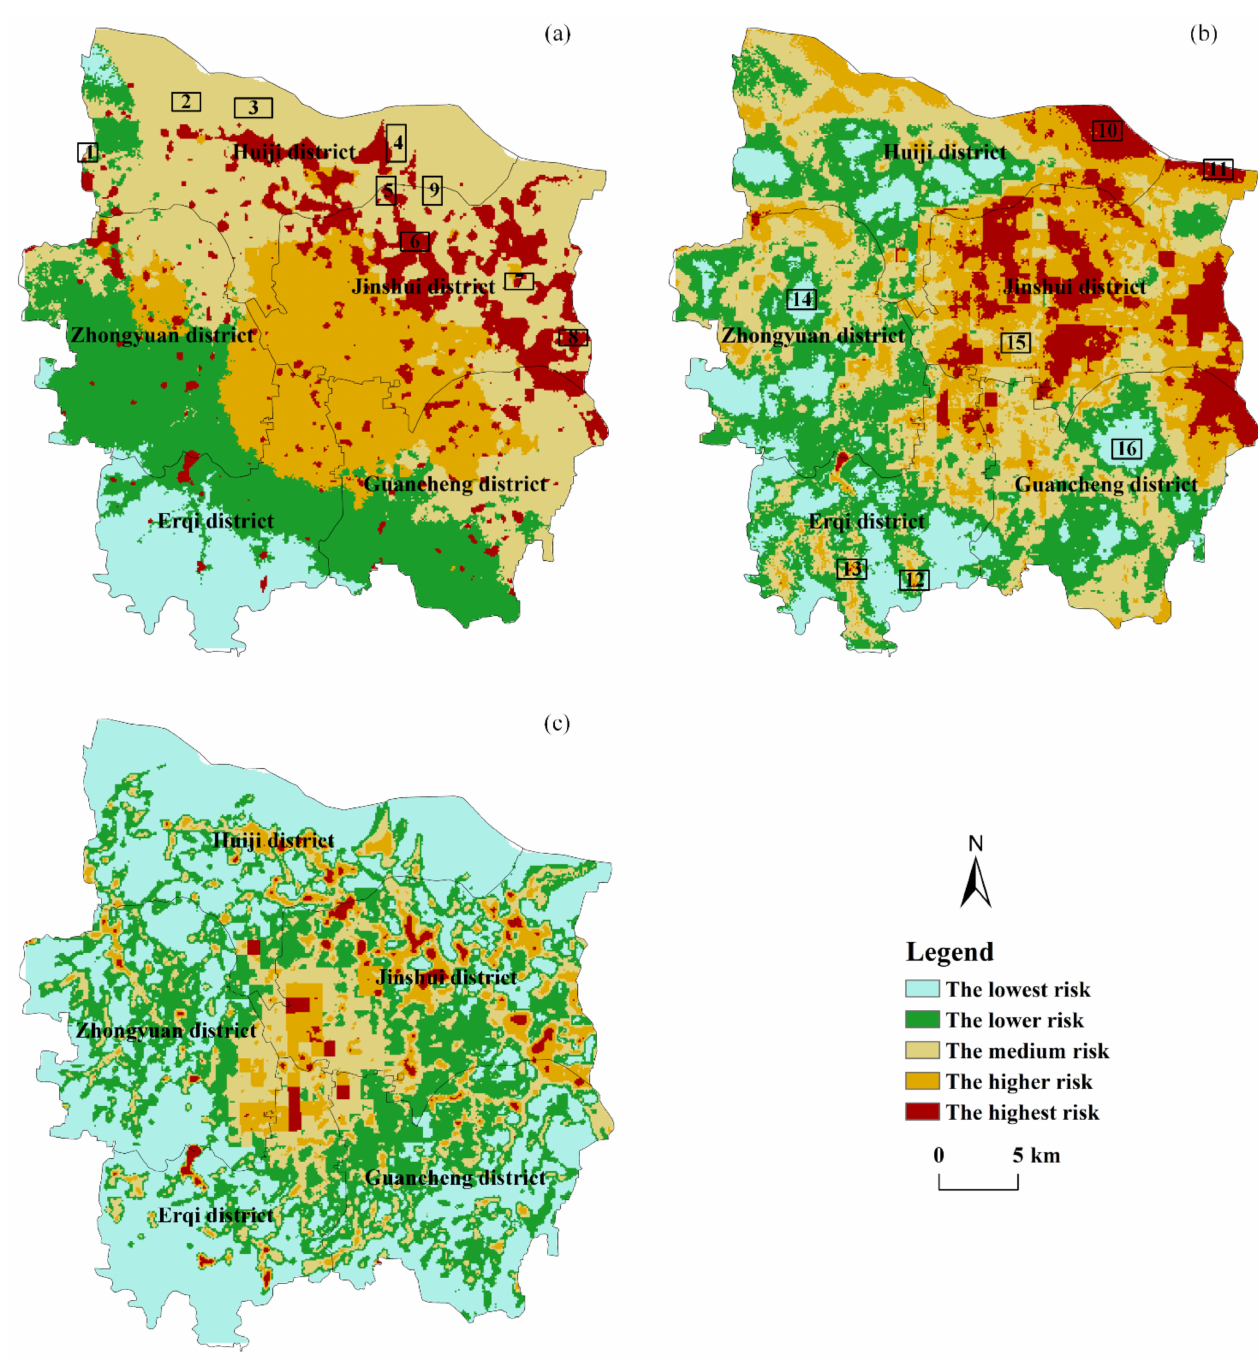
Figure 11. Spatial distribution map of flood risk in Zhengzhou: ( a ) based on the AHP-SOM method; ( b ) based on the D-AHP and natural-breaks method; and ( c ) based on the TOPSIS-with-entropy- weighting method. Areas 1–16 in sub-figures ( a ) and ( b ) were selected to compare the results of different risk assessment